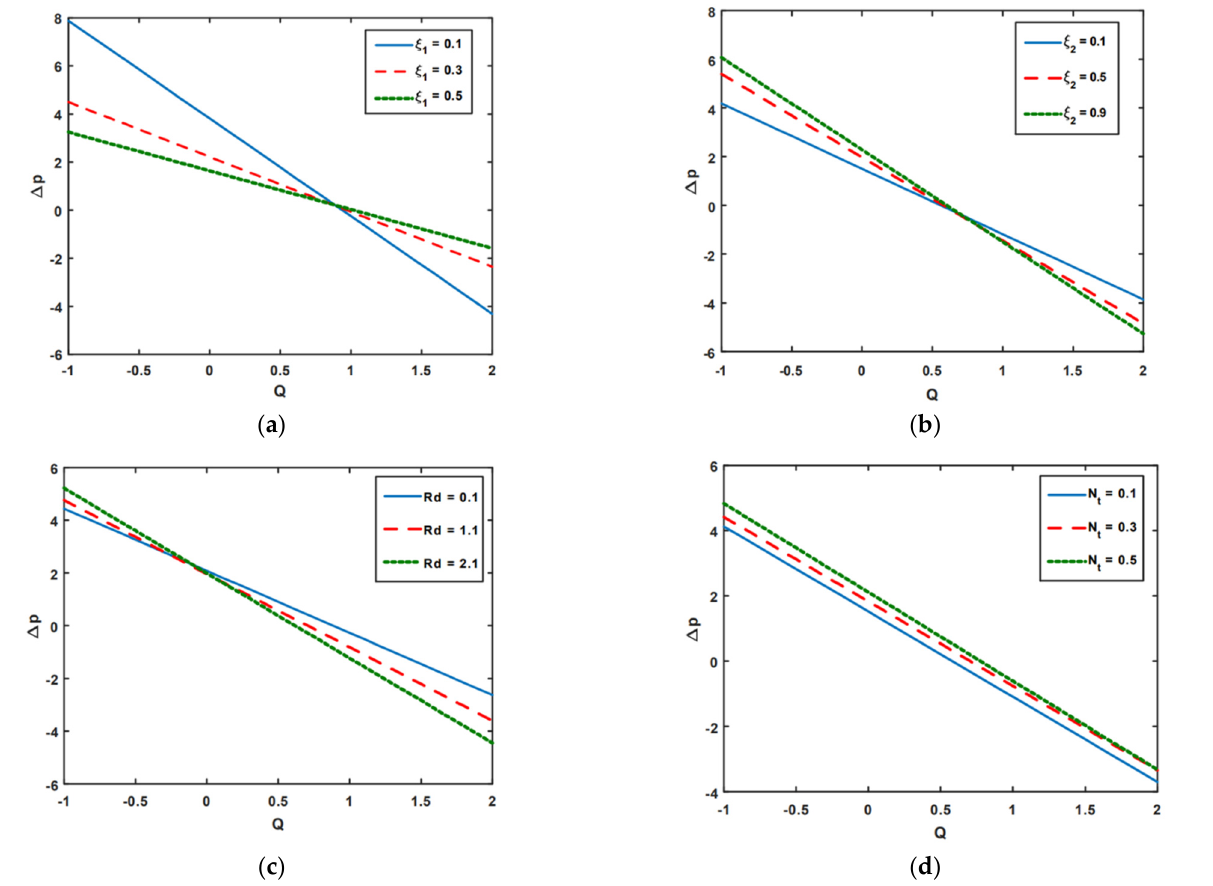
Figure 2. (a–d) Pressure rising impact on 𝜉 (cid:2869) , 𝜉 (cid:2870) , 𝑅𝑑 , and N (cid:2930) . Figure 2. ( a – d ) Pressure rising impact on ξ 1 , ξ 2 , Rd , and N t